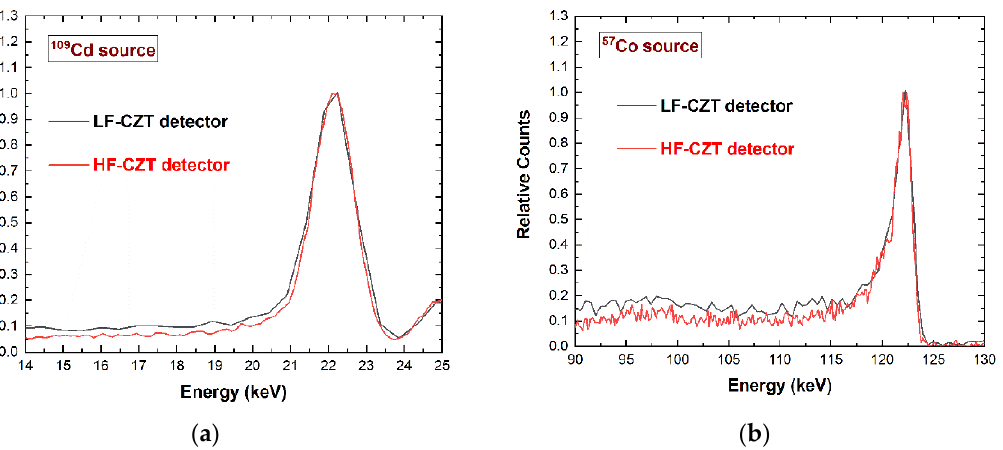
Figure 2. Measured energy spectra of a pixel of the 500 µ m array for the LF-CZT (black line) and HF-CZT (red line) detectors. ( a ) The energy resolution of the main peaks (22.1 keV) of 109 Cd energy spectra is approximately 6% (1.3 keV) FWHM for both detectors. ( b ) The 122 keV peaks of the 57 Co spectra are characterized by an energy resolution of 1.7% (2 keV). To compare the photopeak shapes, the energy spectra are normalized to the photopeak centroid counts.